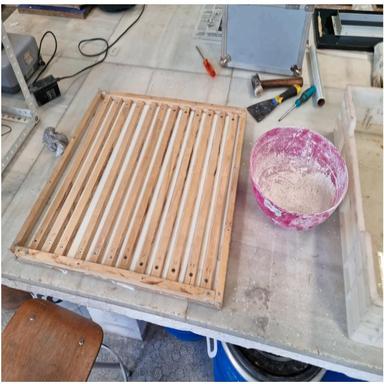
(a) Plate design mould.